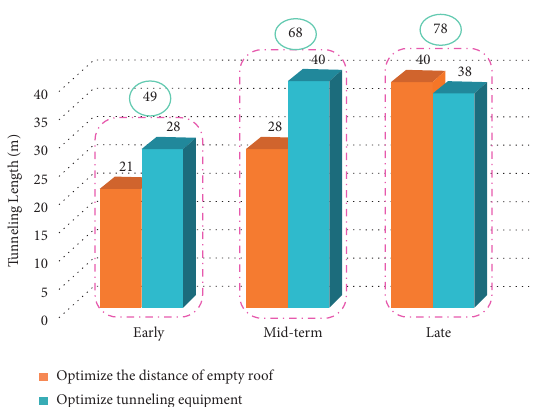
Figure 21: Roadway excavation